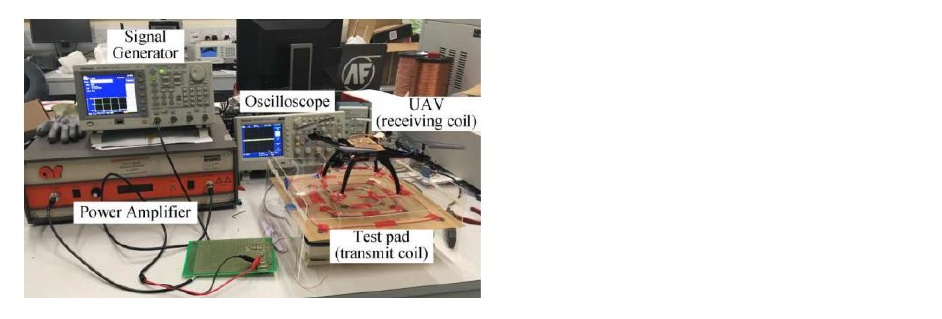
Figure 6. Variable pitch transmitter coil charging drone. Reproduced with permission from Ref. [23]; published by IEEE, 2017.